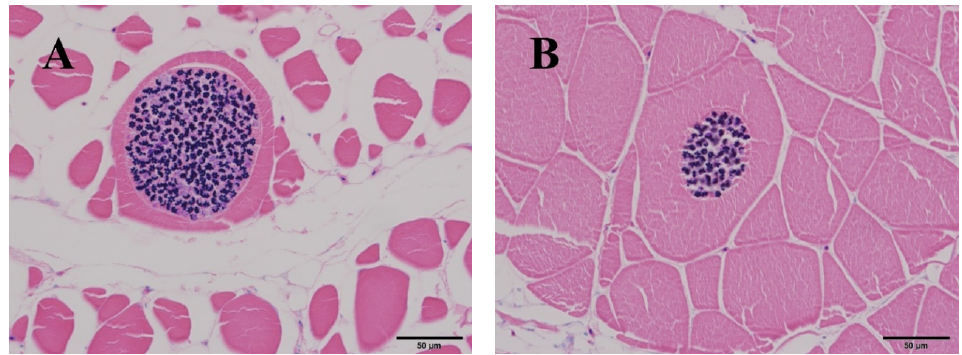
Figure 3. Histological analysis of abdominal and dorsal muscle in Pacific bluefin tuna ( Thunnus orientalis ) positively infected with Kudoa hexapunctata . Giemsa staining revealed: ( A ) abdominal muscle of the fifth sample; ( B ) abdominal muscle of the fifth sample. Scale bar = 50 μm.